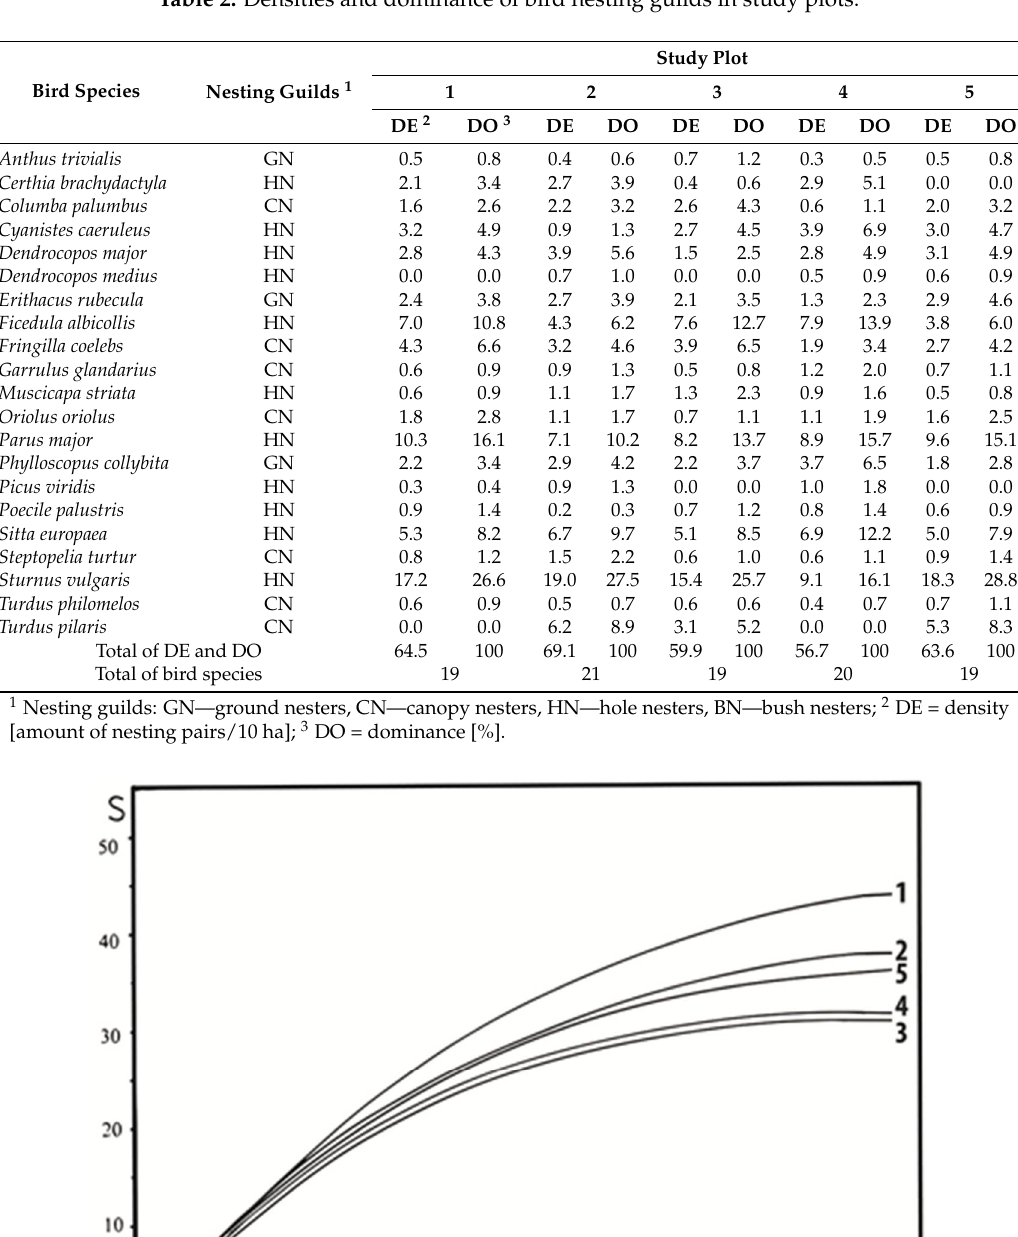
Table 2. Densities and dominance of bird nesting guilds in study plots.